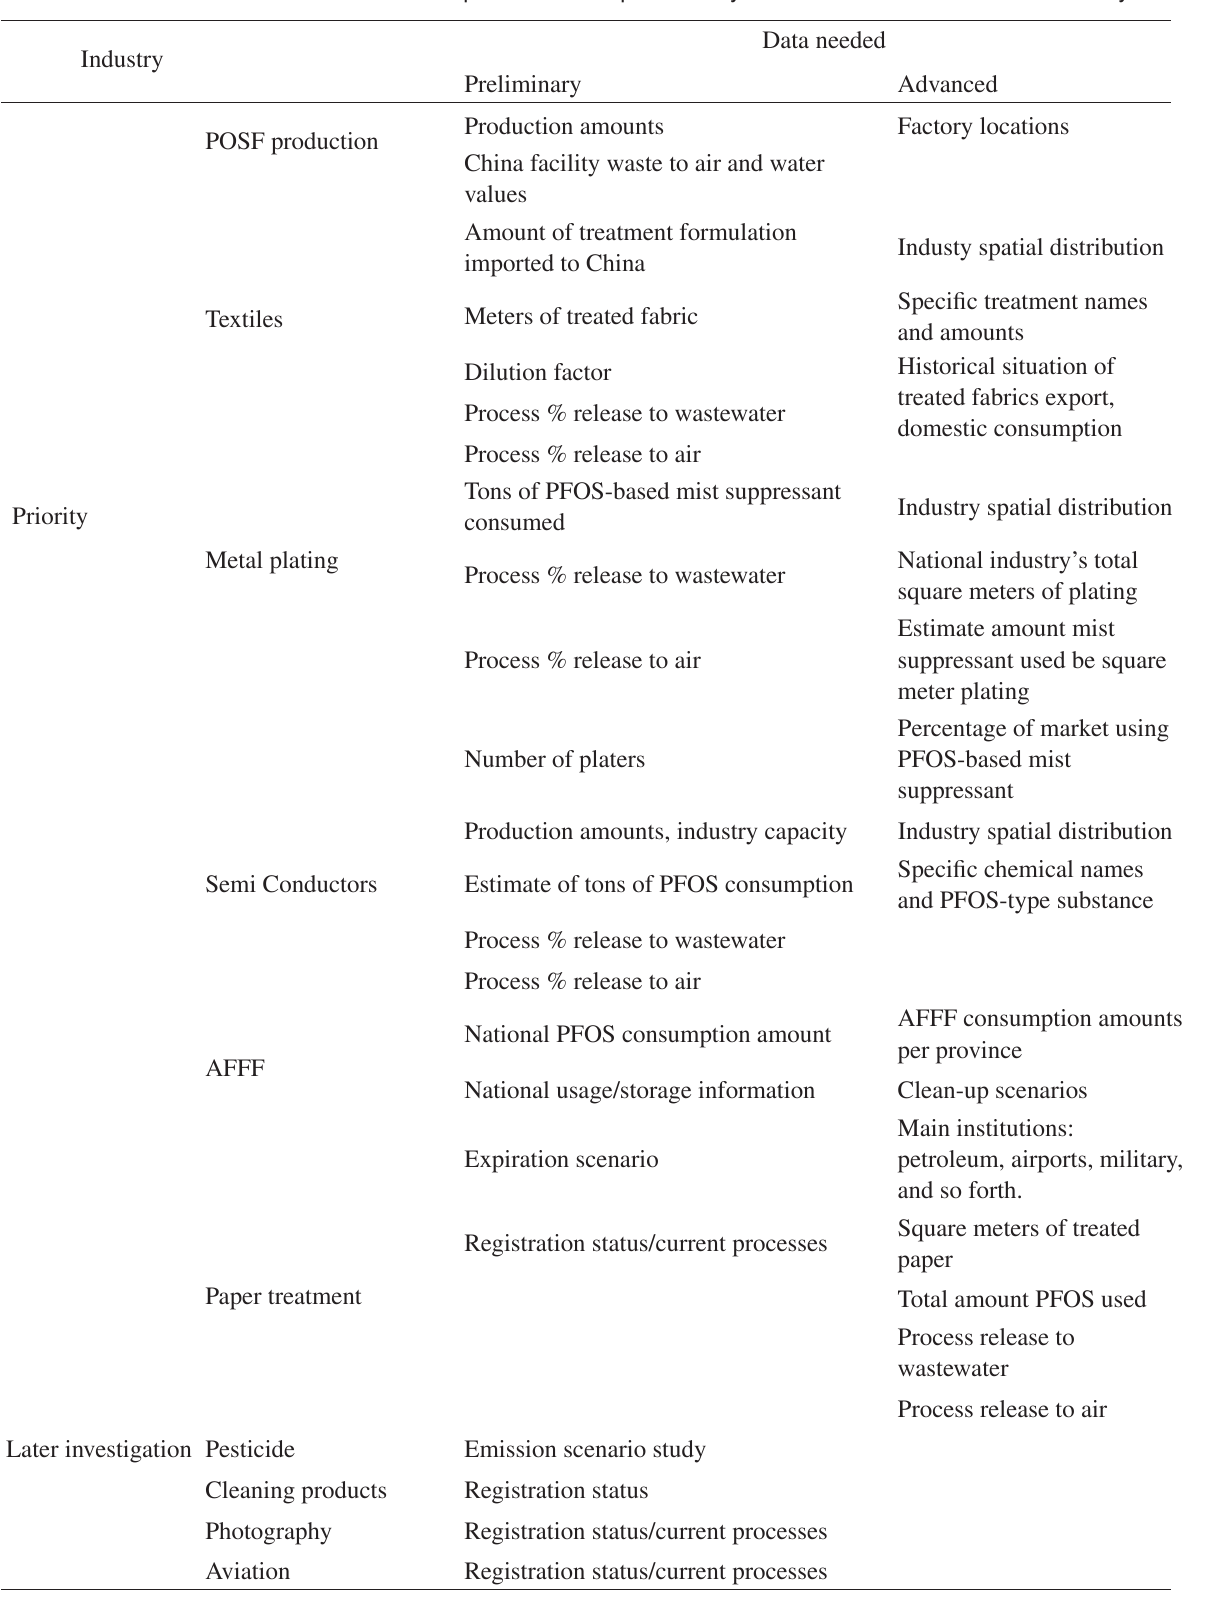
TABLE 4: Prioritized industrial data requirements for preliminary and advanced emissions inventory.